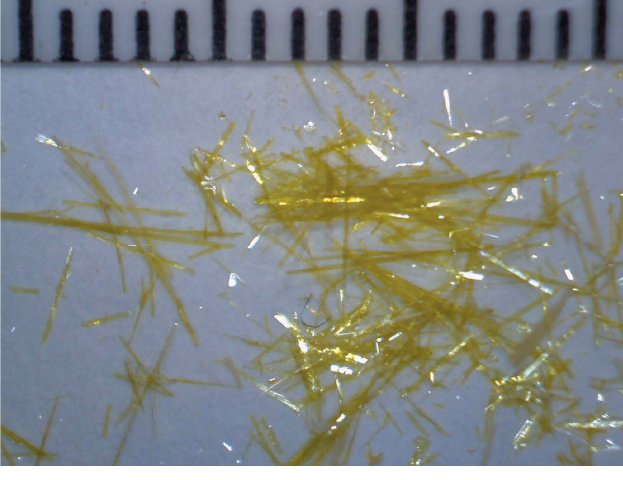
Figure 5 A photograph of crystals of the title compound (1 mm reference scale).